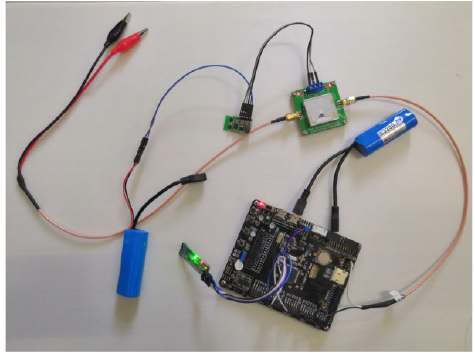
Figure 9. A prototype of wireless transmission module.